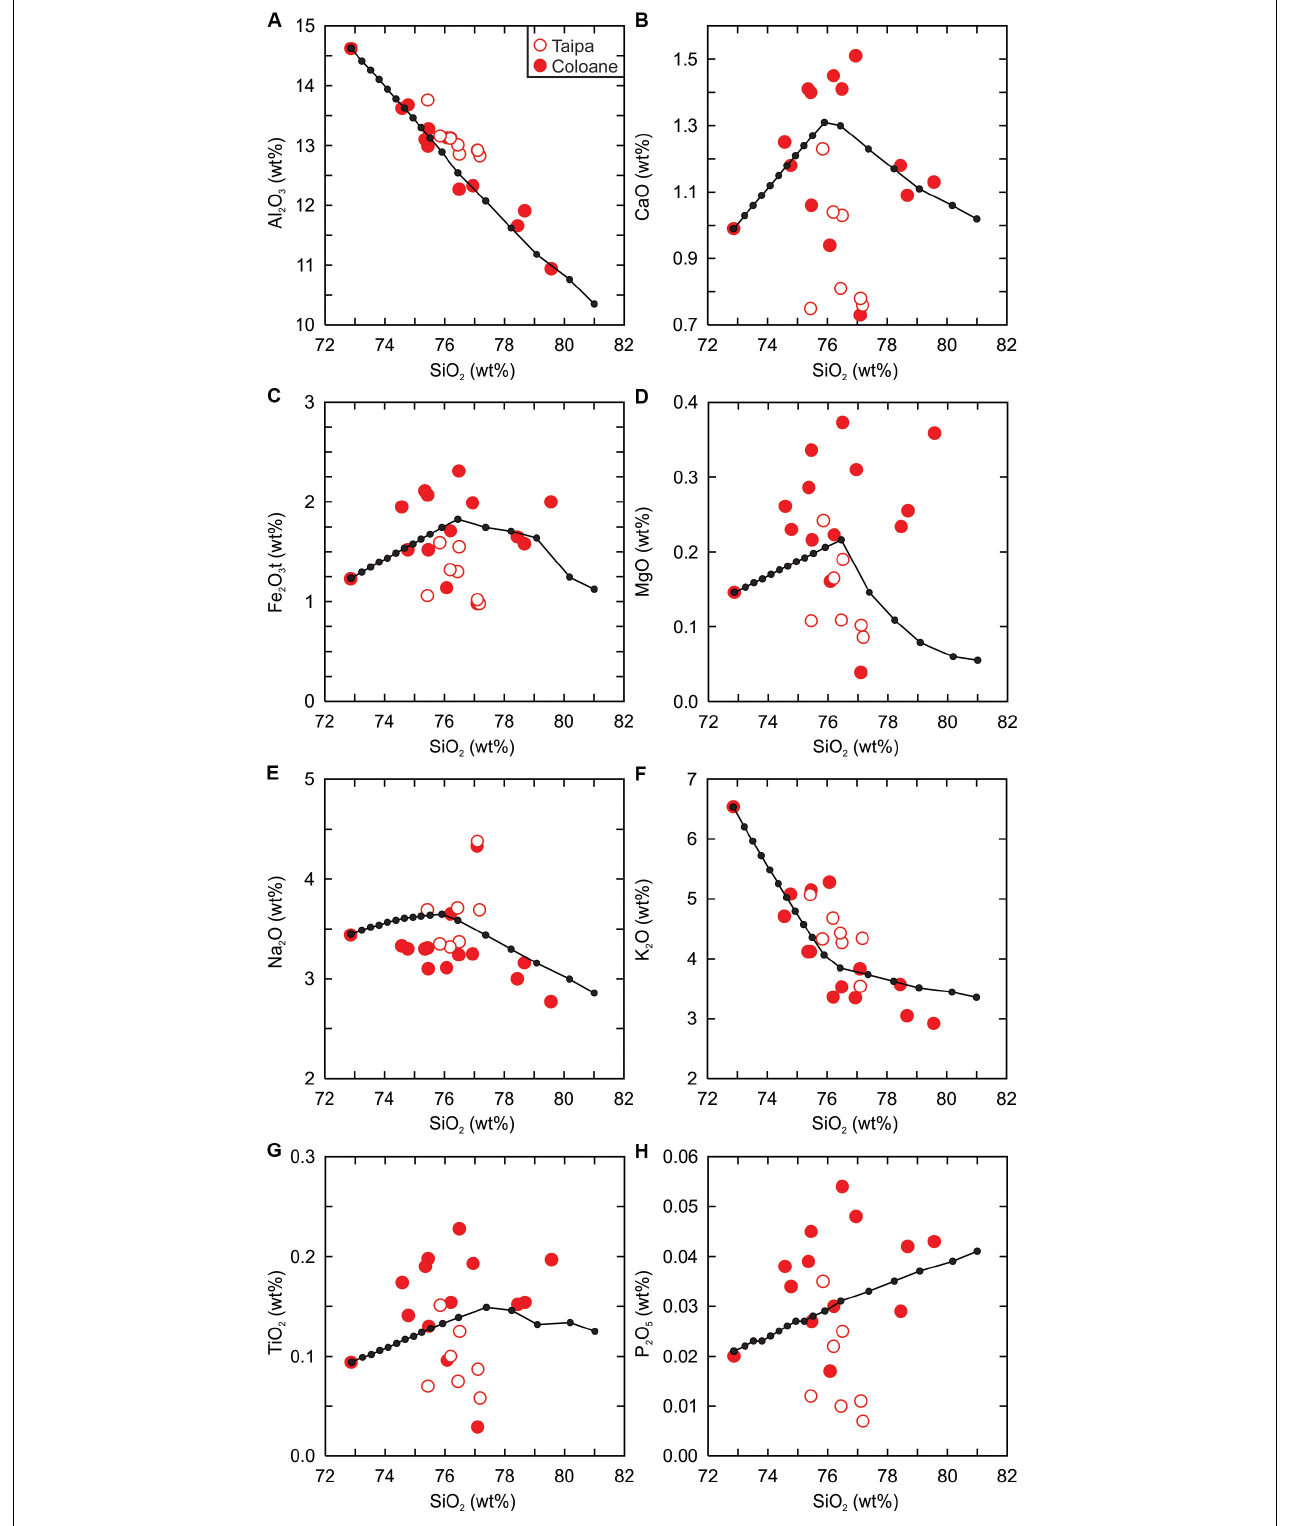
FIGURE 8 | MELTS fractional crystallization modeling of the leucogranites showing the major element liquid composition evolution curves. (A) Al 2 O 3 (wt.%) vs. SiO 2 (wt%), (B) CaO (wt.%) vs. SiO 2 (wt%), (C) Fe 2 O 3 t (wt.%) vs. SiO 2 (wt%), (D) MgO (wt.%) vs. SiO 2 (wt%), (E) Na 2 O (wt.%) vs. SiO 2 (wt%), (F) K 2 O (wt.%) vs. SiO 2 (wt%), (G) TiO 2 (wt.%) vs. SiO 2 (wt%), and (H) P 2 O 5 (wt.%) vs. SiO 2 (wt%). The model shows the liquid compositions at 10 ◦ C intervals (solid black dots). All data recalculated on an anhydrous basis.